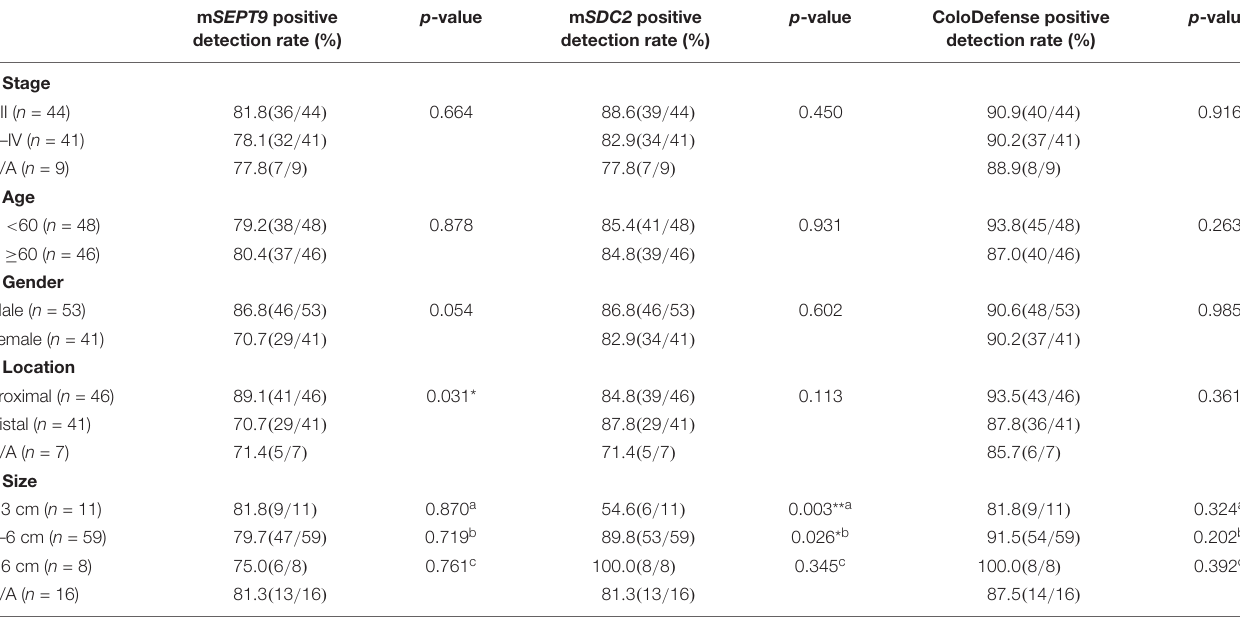
FIGURE 3 | Performance of ColoDefense test in detecting control, AA and CRC across stages I–IV in the validation set. (A) Positive detection rates for control and all stages of CRC. (B) ROC curves for ColoDefense test in detecting CRC. TABLE 4 | Results of ColoDefense test in detecting CRC for different stage, age groups, genders, tumor locations, and tumor